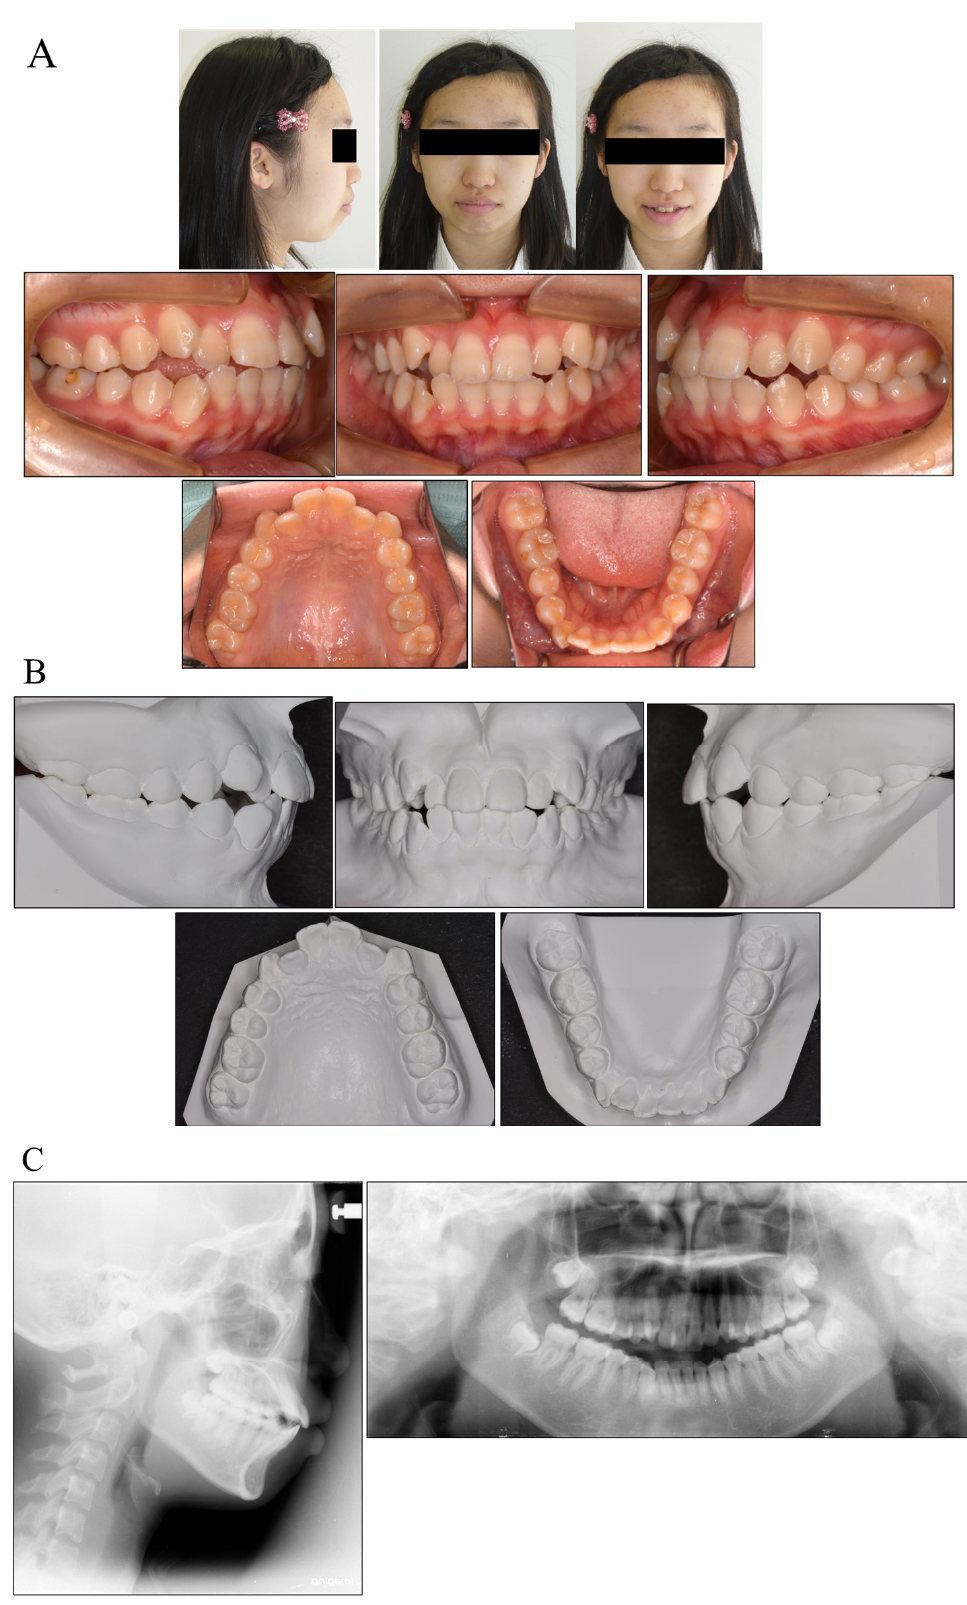
Figure 2. Facial and intraoral photograph ( A ), dental casts ( B ) and radiographs (( C ) lateral cephalo- gram; panoramic radiograph) of pretreatment (patient is 15 years old).